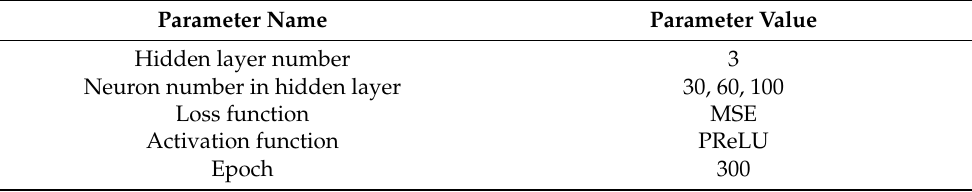
Table A1. RNN configuration and parameters used to train RNN